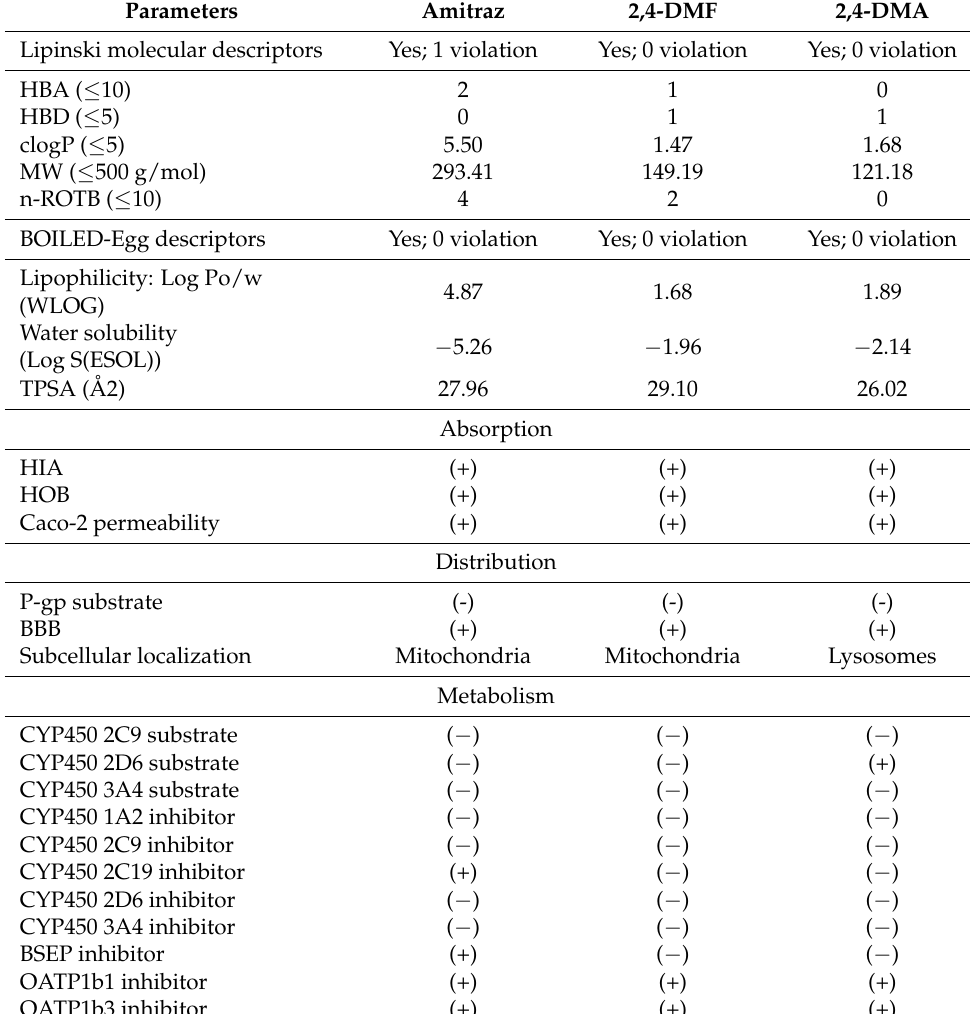
Table 2. The ADME and toxicity profile prediction for amitraz, 2,4-DMA, and